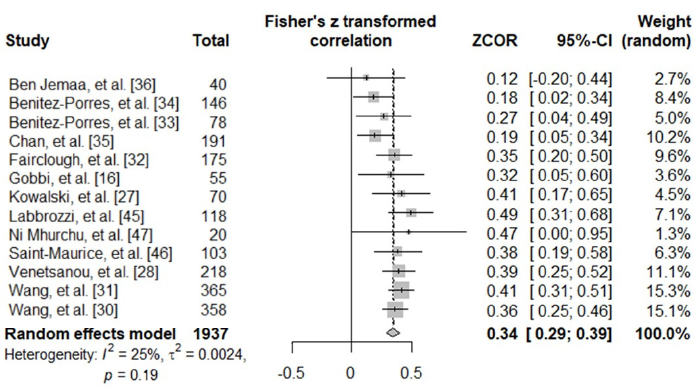
Figure 2. Forest plot showing the relative and pooled correlations between PAQ-C and MVPA scores of the included studies.